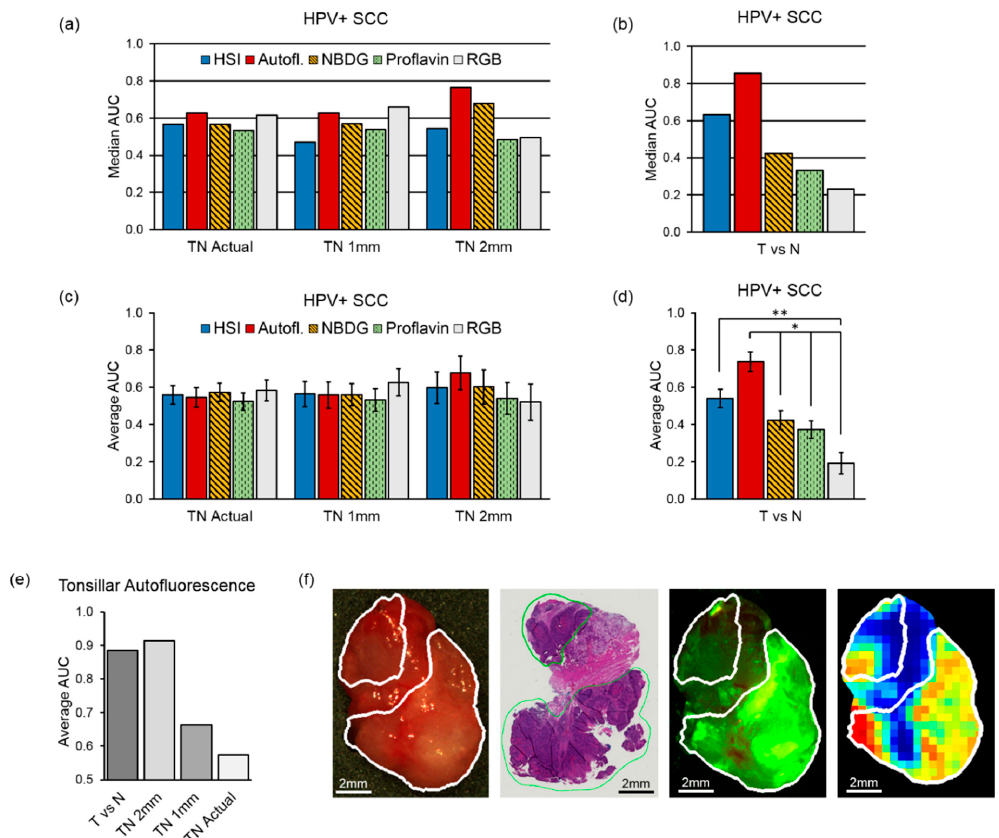
Figure 4. Median and average AUC results from inter-patient classification (a value of 0.5 corresponds to random guess). AUC values for the HPV + SCC cohort: ( a ) median AUC values TN margin specimens; ( b ) median AUC values T and N whole specimens; ( c ) average AUC of TN margin specimens with SEM; ( d ) average AUC of T and N whole specimens shown with SEM and statistical significance, shown as (*) for p < 0.05 and (**) for p < 0.01; ( e ) Average AUCs of HPV + SCC in tonsillar tissues; ( f ) Representative patient example of HPV + SCC in tonsillar tissue from the oropharynx. From left to right: RGB made from HSI, histology ground truth, and predicted cancer heat-map. The white and green contours outline the SCC area.